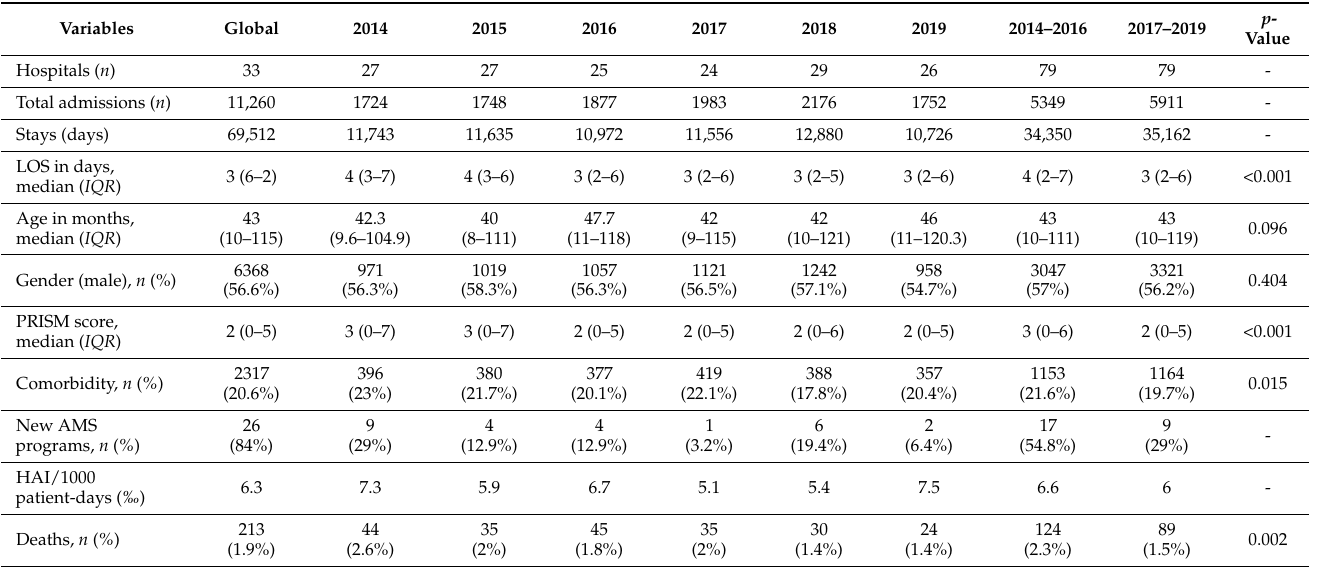
Table 2. Description of the